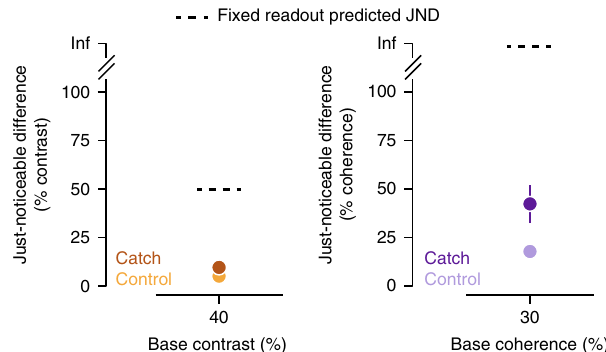
Fig. 8 Perceptual sensitivity on catch trials. Just-noticeable differences (JNDs) for contrast (left) and coherence (right) are shown for the regular (control, light colors) and catch (dark colors) trials during runs that included catch trials. Dashed lines indicate the predicted JNDs for catch trials for the fi xed readout model. Markers indicate the average across observers and error bars the 95% con fi dence intervals, some error bars are hidden by the between bright and dark, and coherence, the percentage of dots